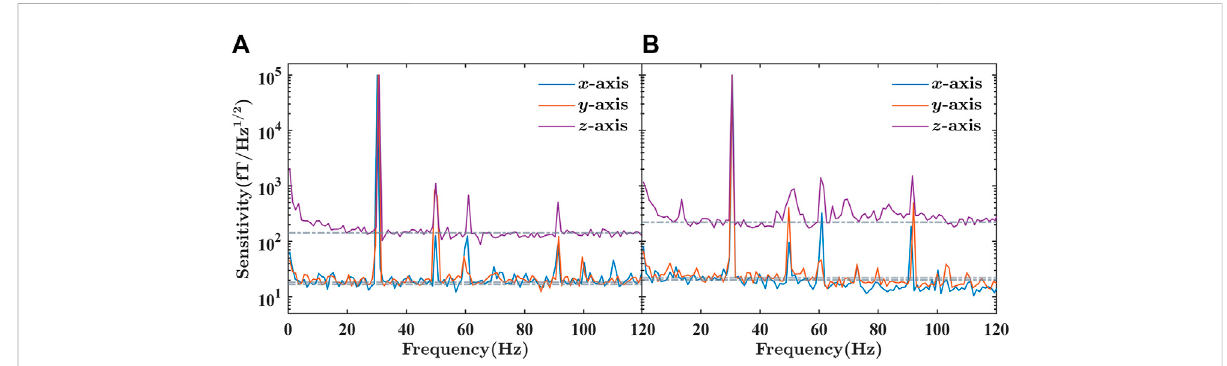
FIGURE 6 The magnetic measurement sensitivity spectra along the three axes on different conditions. The maximum peak in each spectrum is the 100 pT rms magnetic calibration signal at 30.5 Hz. (A) The magnetic measurement sensitivity spectra with the same parameters as that in simulation. The magnetic fi eld sensitivity is 18 fT/Hz 1/2 along x -axis, 18 fT/Hz 1/2 along y -axis, and 140 fT/Hz 1/2 along z -axis. (B) The magnetic measurement sensitivity spectra on condition of closed-loop high bandwidth and large dynamic range con fi guration. The triaxial sensitivities are 22 fT/Hz 1/2 along x -axis, 22 fT/Hz 1/2 along y -axis, and 230 fT/Hz 1/2 along z -axis, maintaining at the high